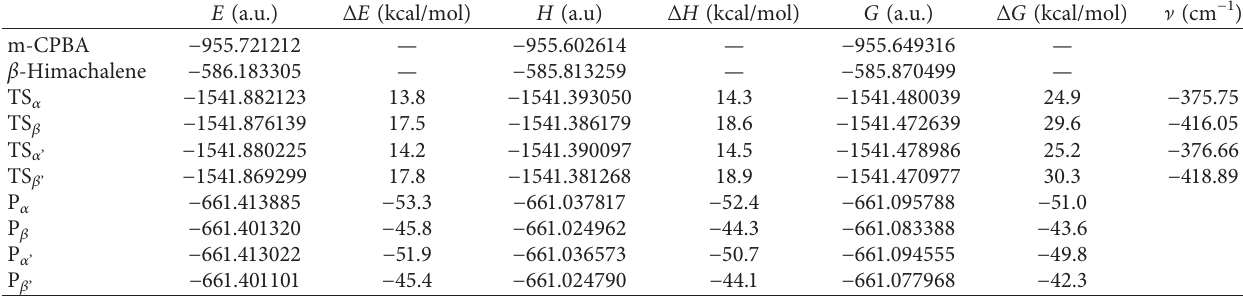
Table 3: Thermodynamic energies of the reaction between β -himachalene and m-CPBA calculated using DFT/6-311+G (d, p). E (a.u.) ∆ E (kcal/mol) H (a.u)